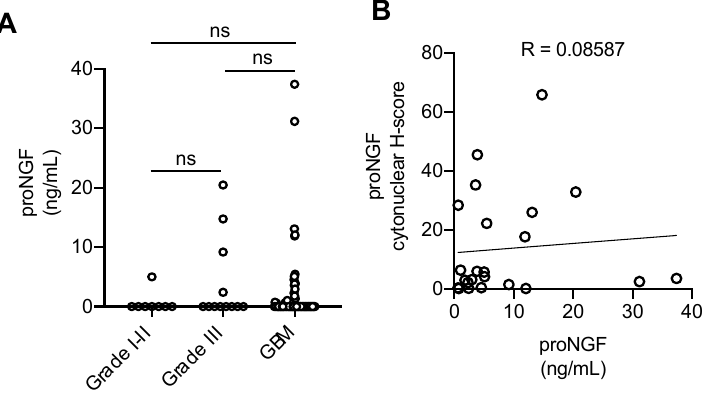
Figure 2. Plasma concentration of proNGF in GBM vs. low grade gliomas ( A ). ProNGF plasma